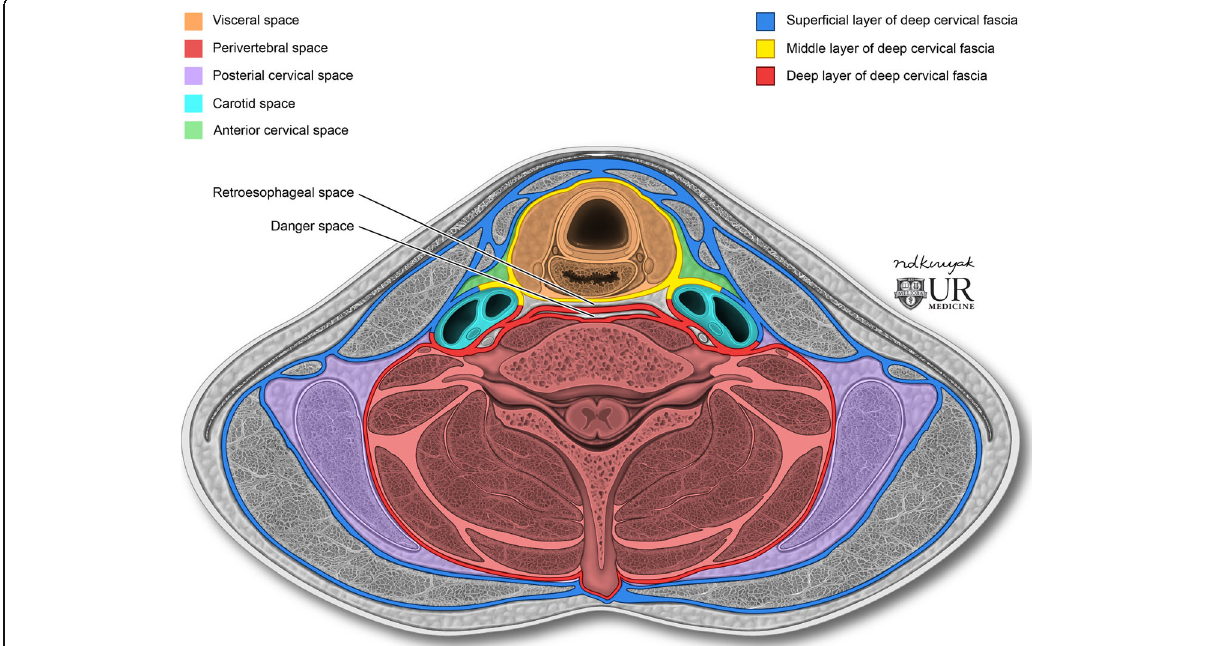
Fig. 2 Infrahyoid deep neck spaces. The carotid space (CS) contains the cranial nerves IX – XII, internal jugular vein, and the internal carotid artery. The retropharyngeal space (RPS) is anterior to the vertebral column. The suprahyoid RPS contains fat and medial and lateral RPS nodes whereas the infrahyoid RPS contains fat only. The danger space (DS) is a potential space in the posterior RPS, separated from the anterior RPS by a facial “ trap door ” , approximately at the level of T3. RPS infection or tumor may spread to the mediastinum via this route. The visceral space (VS) contains thyroid and parathyroid glands, trachea, esophagus, recurrent laryngeal nerves, and pretracheal and paratracheal nodes. The posterior cervical space (PCS) contains fat, CNXI, and level V nodes. The perivertebral space (PVS) includes the prevertebral PVS and the paraspinal PVS. The prevertebral PVS contains brachial plexus and phrenic nerve, vertebral body, veins, arteries, and prevertebral and scalene muscles within. The paraspinal PVS contains only posterior vertebra elements and paraspinal muscles